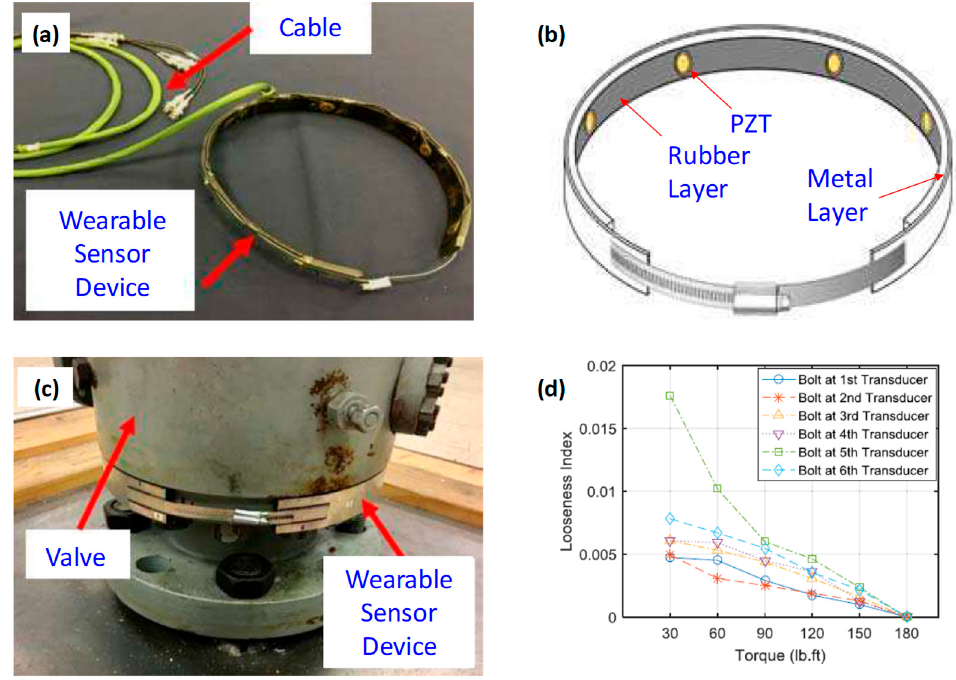
Figure 13. Impedance-based SHM of a valve using wearable technique: ( a ) wearable sensor device, ( b ) layout of the device, ( c ) device mounted on a valve, and ( d ) loosening index vs. bolt torque (adapted from [103] ).